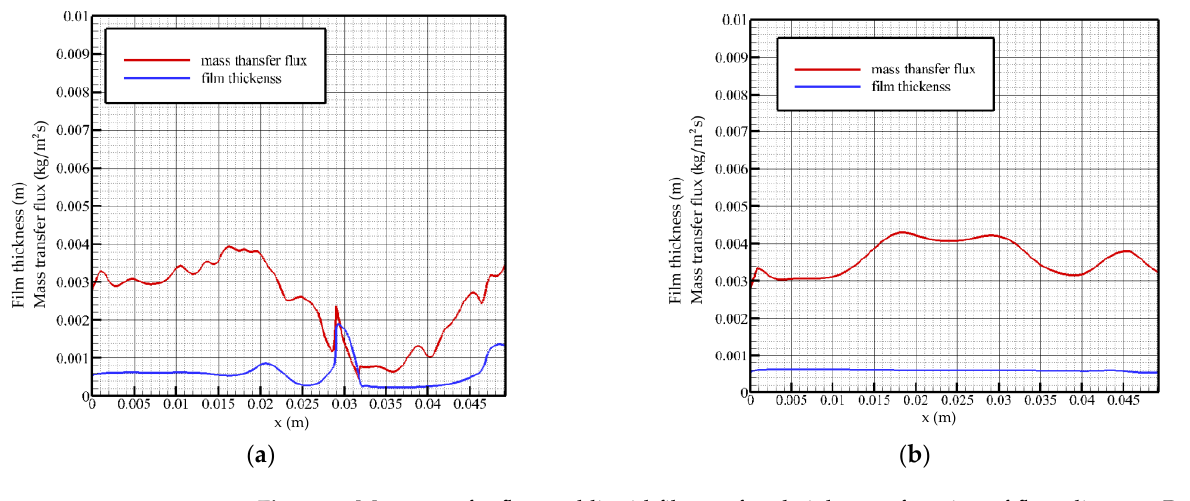
Figure 6. Mass transfer flux and liquid film surface height as a function of flow distance, Re = 40. ( a ) t = 0.76 t 0 , ( b ) t = 2 t 0 . ( a ) t = 0.76 t 0 , ( b ) t = 2 t 0